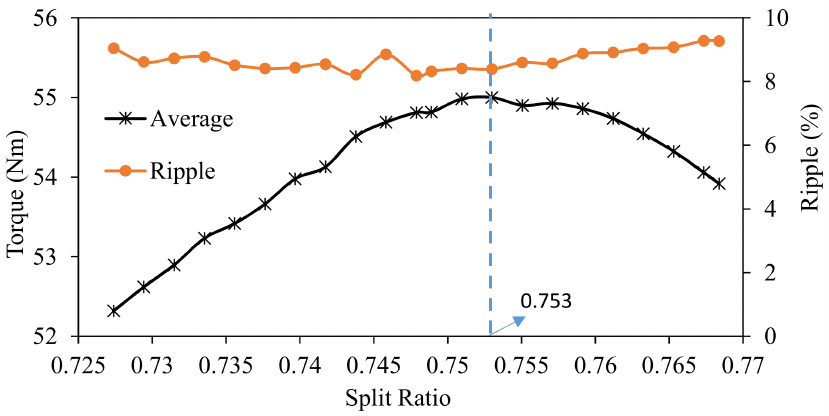
Figure 36. Average torque and torque ripple against the split ratio.